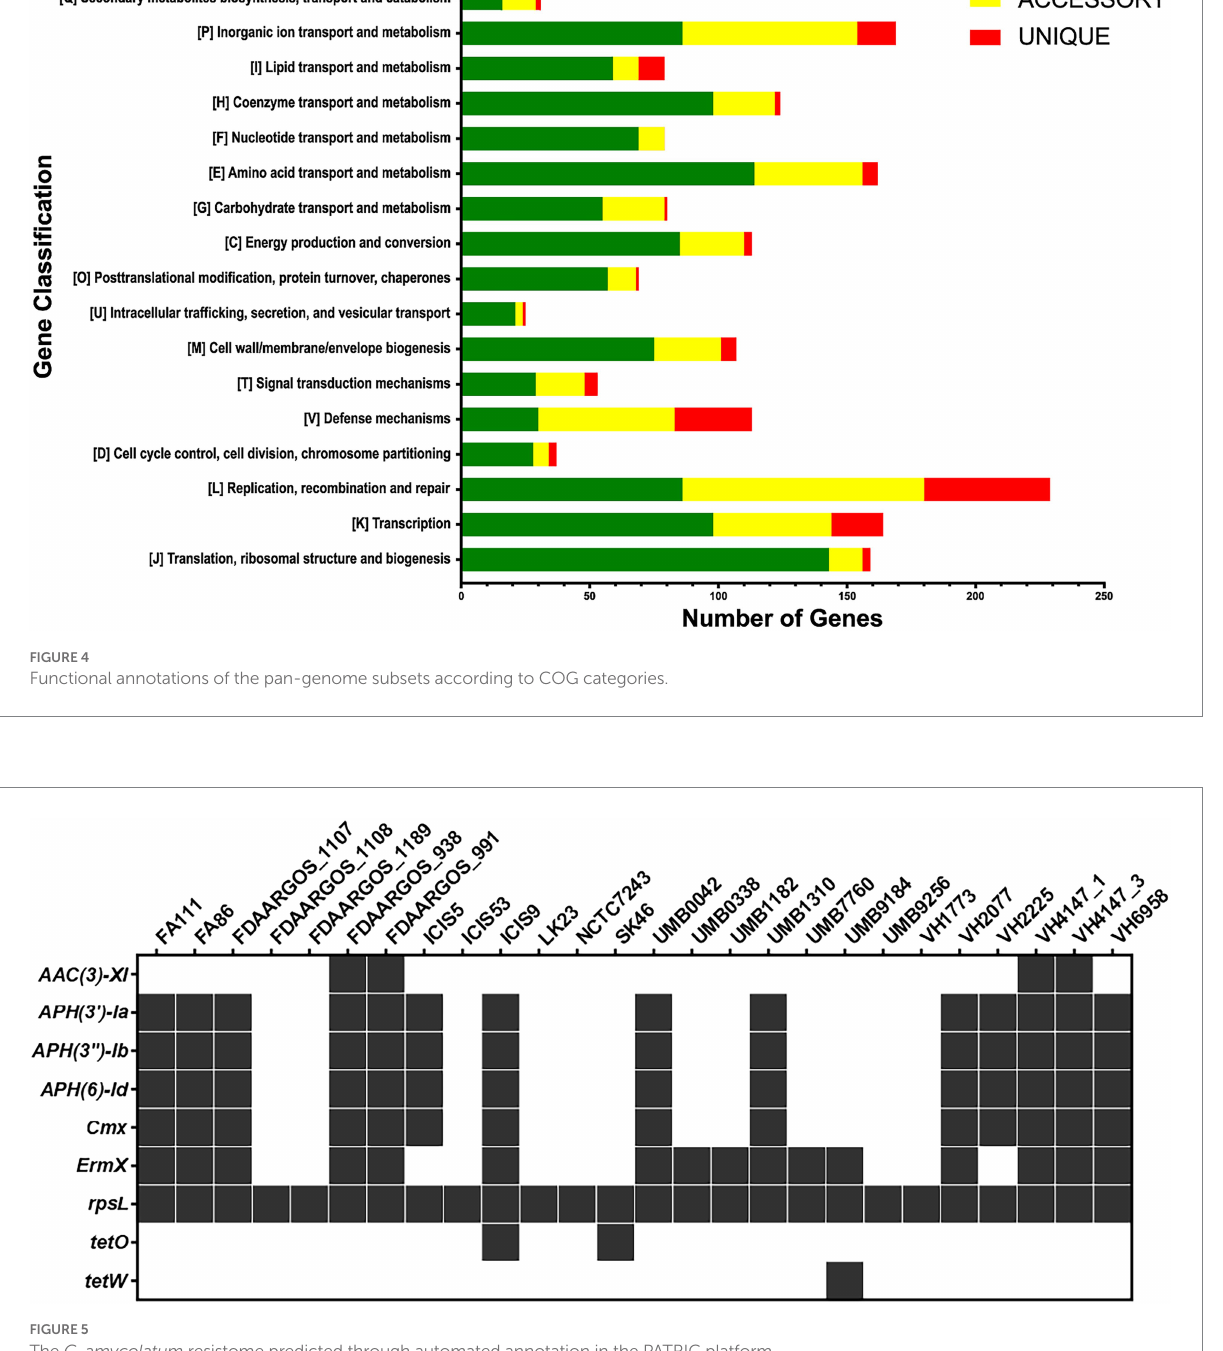
Apart from the rpsL gene, all other predicted AMRs co-localize with predicted genomic islands in the studied genomes (Figure 6). The genes cmx , aph(3 ′ )-Ia , aph(3 ″ )-Ib , aph(6)-Id were